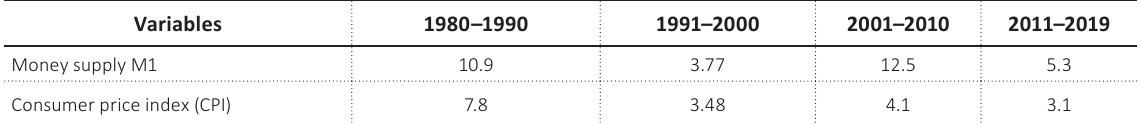
Source: Calculated by the researcher according to Table 1.